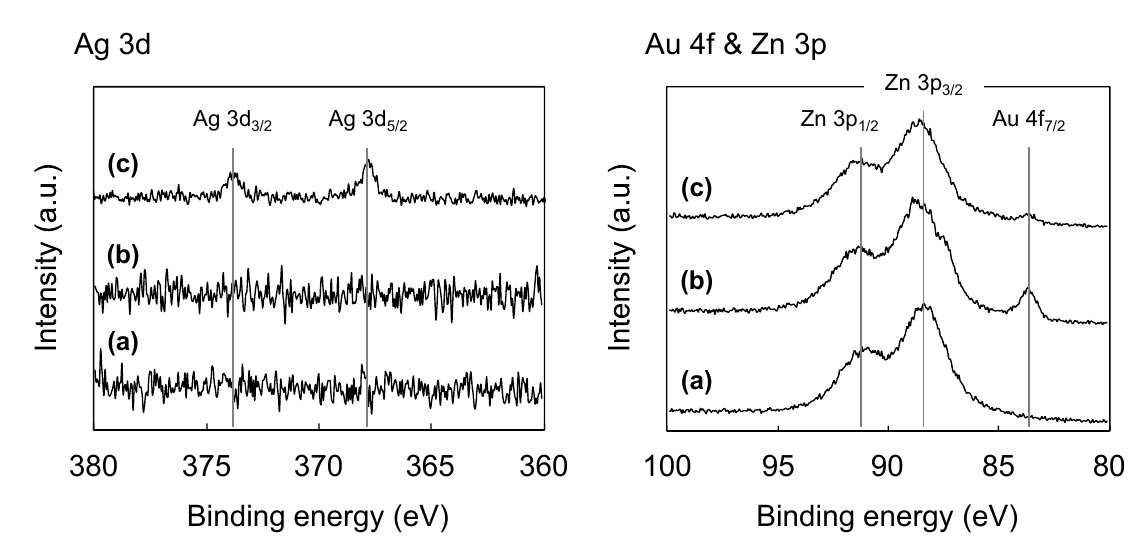
Figure 3. XPS spectra for ( a ) the original ZnO whiskers, and ZnO whiskers treated with and ( c ) HAuCl and AgNO ( b ) HAuCl 4 4 3